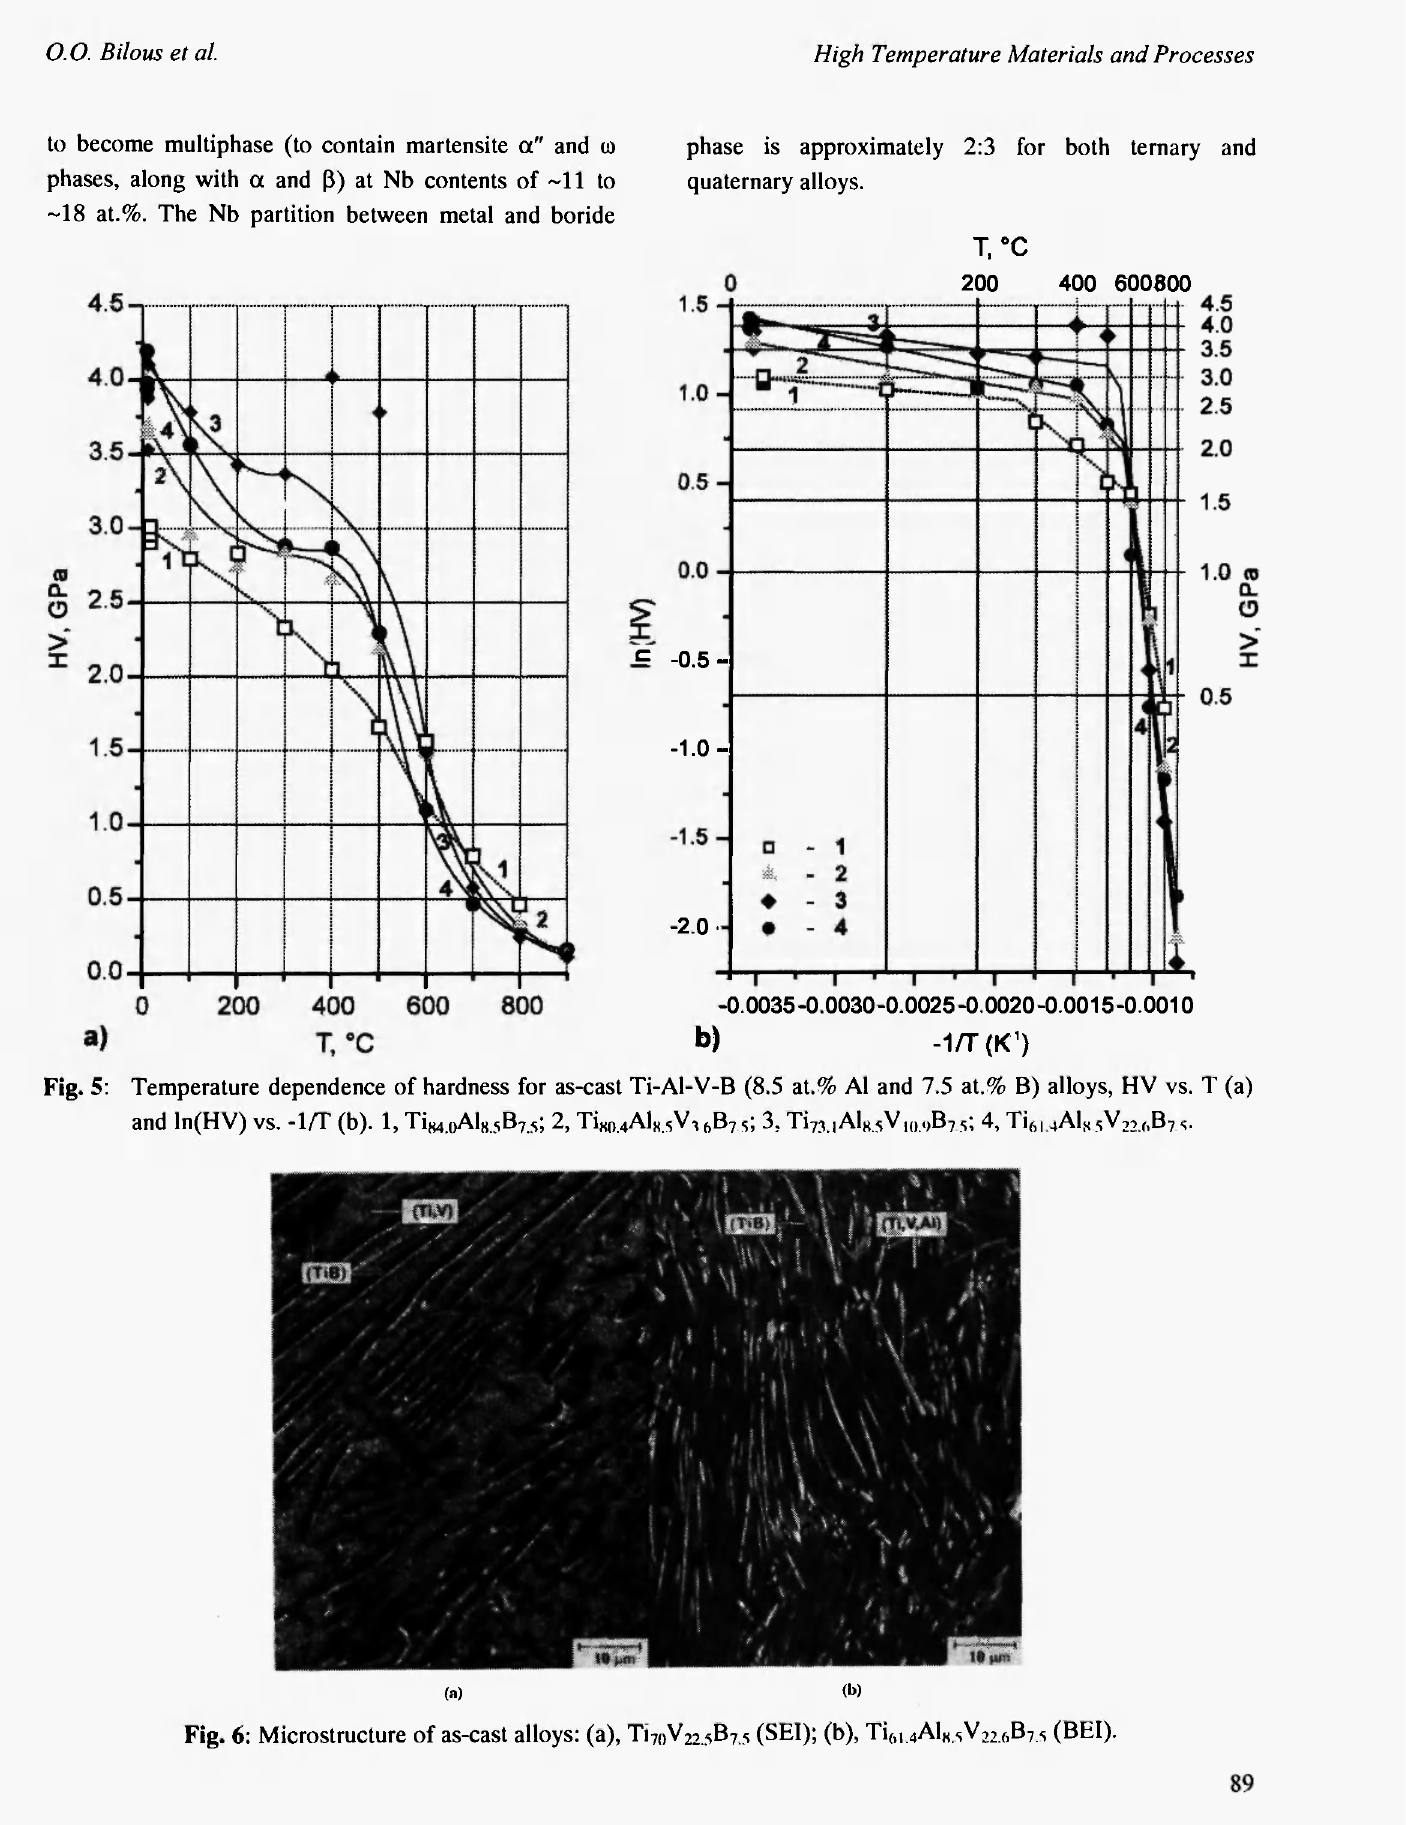
Fig. 6: Microstructure of as-cast alloys: (a), T ito V^B? 5 (SEI); (b), Ti 6 i 4Als.sV22.6B7 s